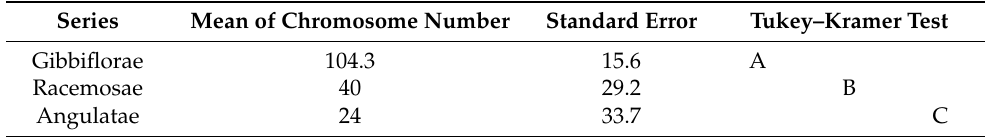
Table 3. Results of the post hoc Tuckey–Kramer test comparison between the species of series: Gibbiflorae, Racemosae, and